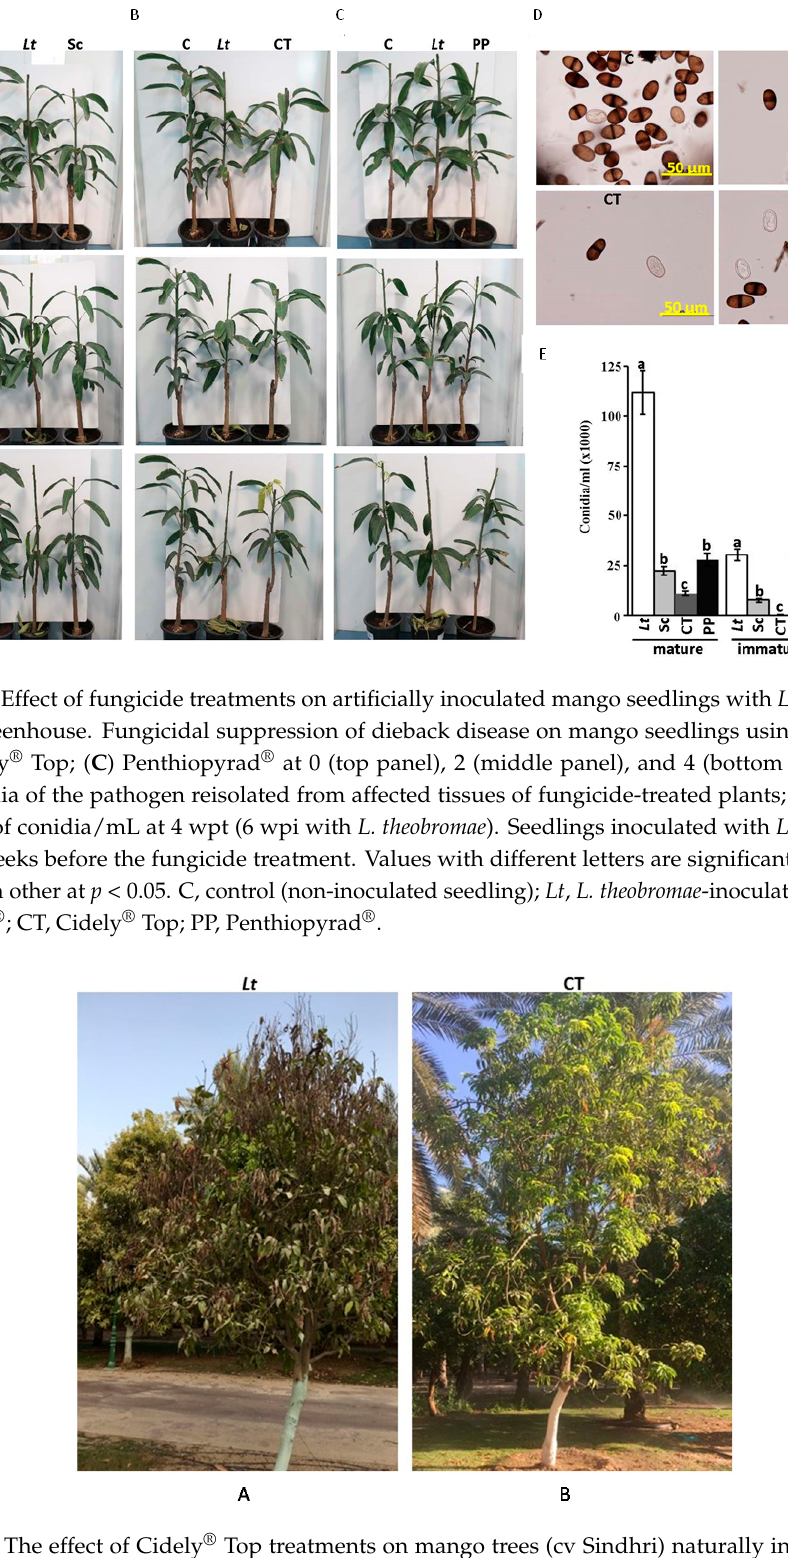
Figure 7. The effect of Cidely ® Top treatments on mango trees (cv Sindhri) naturally infected with L. theobromae in the field. Fungicidal suppression of dieback disease symptoms on mango trees ( n = 12) non-treated ( A ) and treated with the fungicide Cidely ® Top ( B ) at 12 wpt. The photo on the left shows the condition of a diseased, affected tree; however, on the right, it shows another tree which was previously affected and has already recovered from severe disease symptoms.